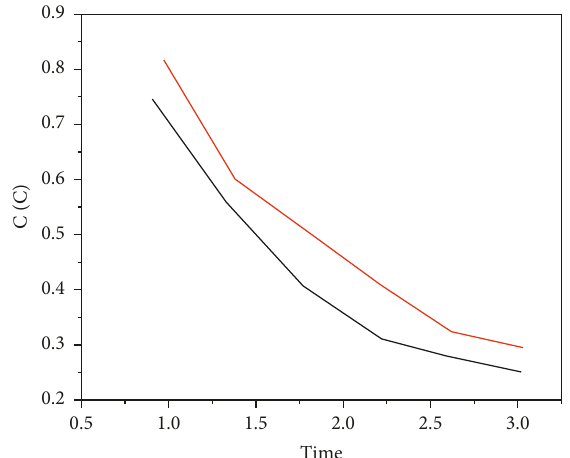
Figure 3: Degradation of acid fuchsin by-products A1 and A3.